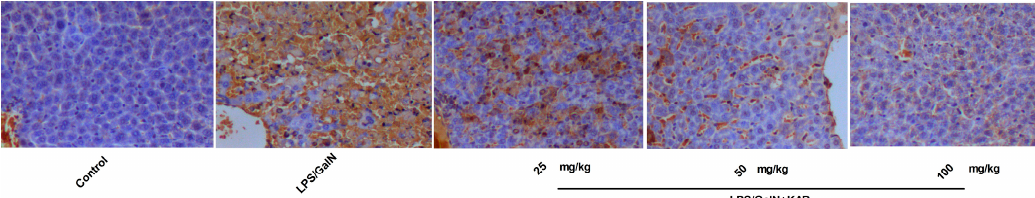
Figure 6. TUNEL assay was used to evaluate the effect of KAR on the in situ apoptosis in the liver control group ( 1 ), FHF model group ( 2 ), and KAR treatment group ( 3 – 5 ) (magnification 200×). LPS substantially induced apoptosis in liver, and the administration of KAR significantly improved it in a dose-dependent manner.